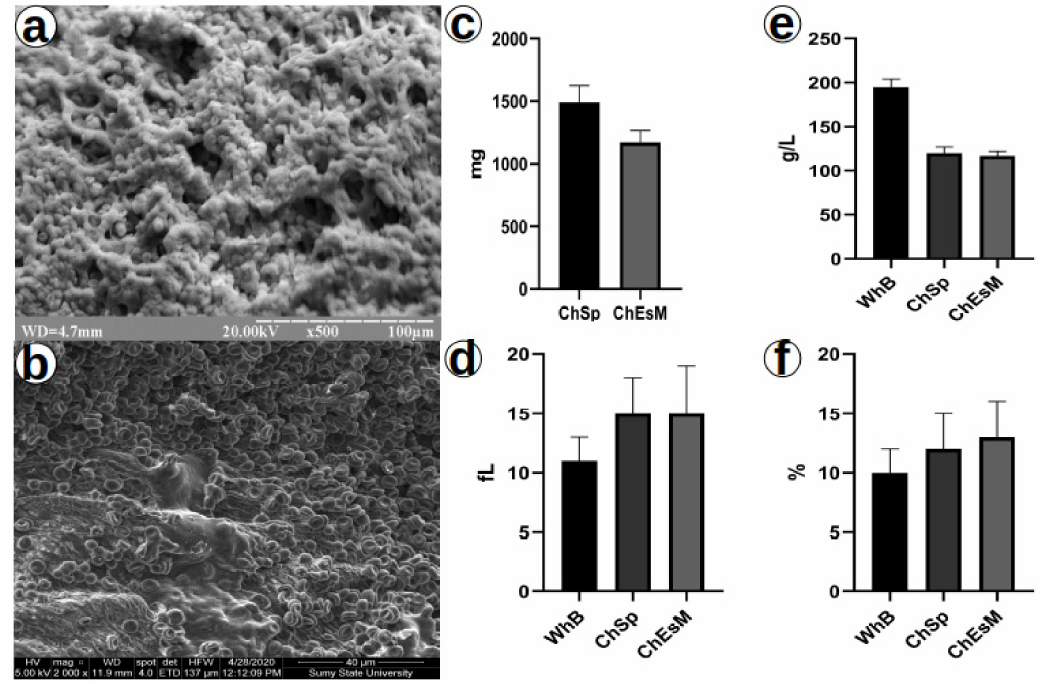
Figure 6. SEM of ChSp ( a ), ChEsM ( b ), blood sorption ( c ) and hematological parameters: platelet ( e ), platelet distribution width ( d ) and mean platelet volume ( f ) after interacting with